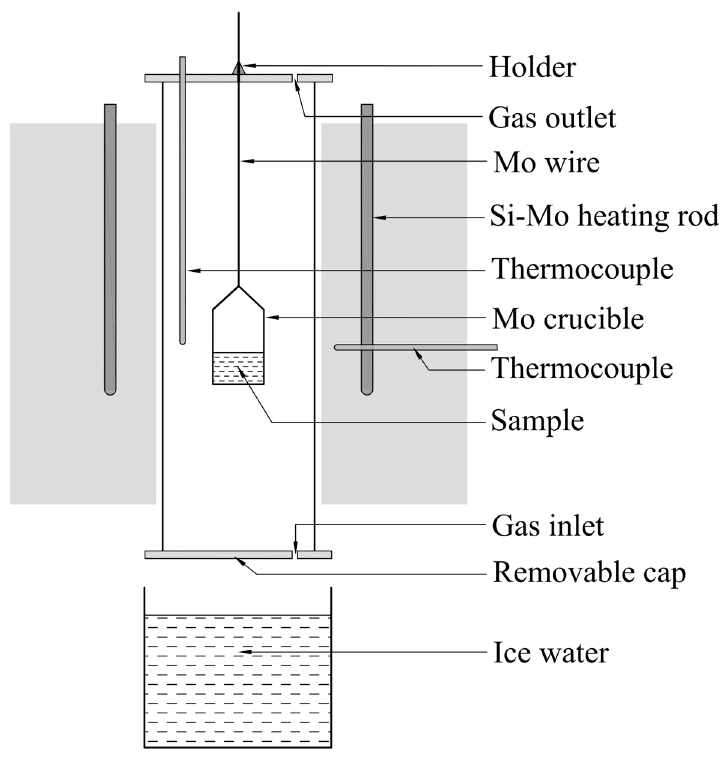
Figure 1. Schematic diagram of high temperature furnace.